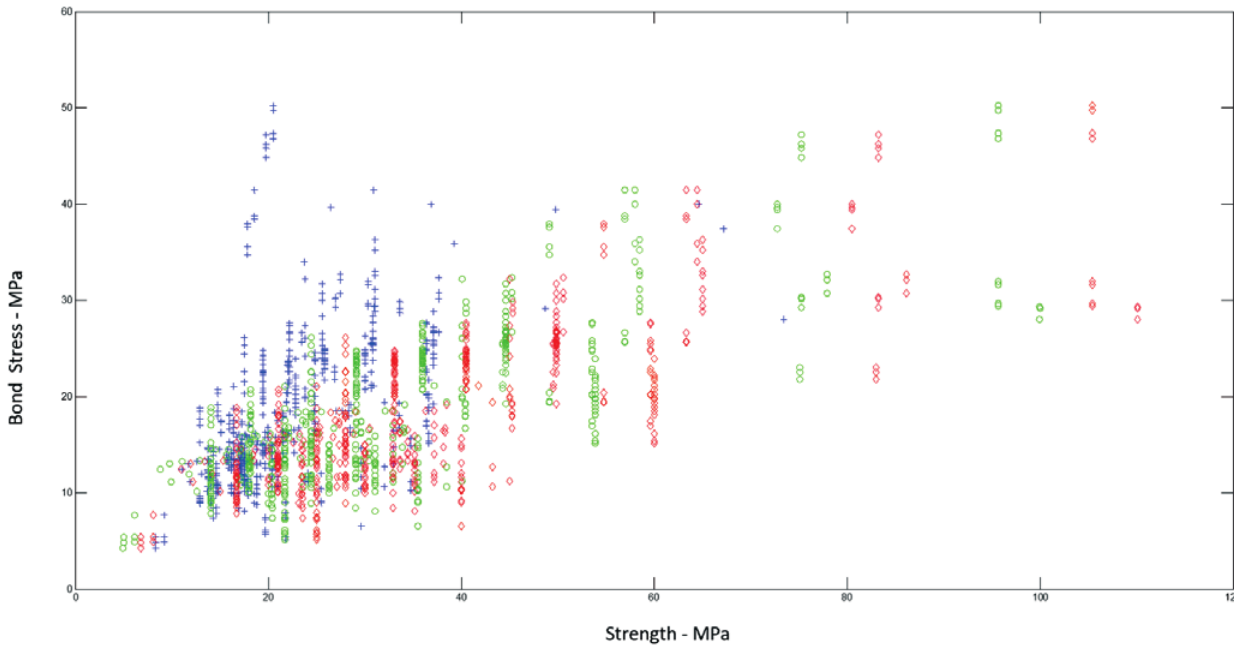
Artificial Neural Network modeling - ANN